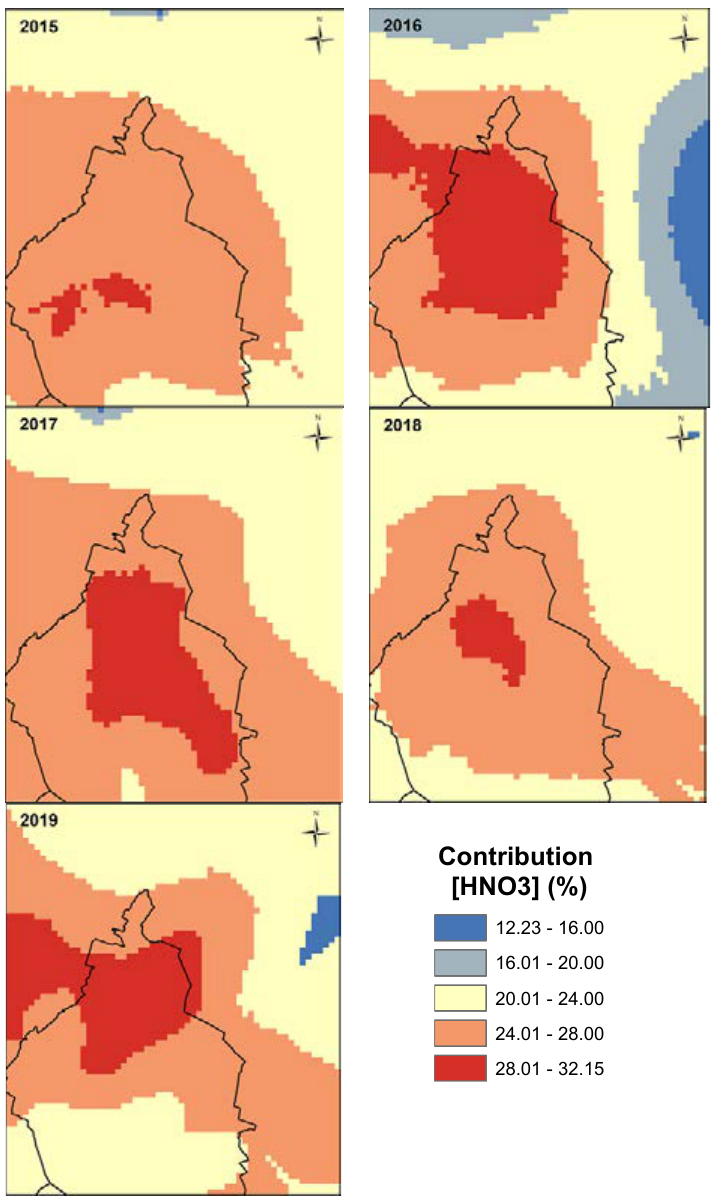
Fig. 6: Maps of the contribution (%) of HNO 3 to the annual zinc corrosion rate (g/m 2 ) of zinc, for a multi-pollutant